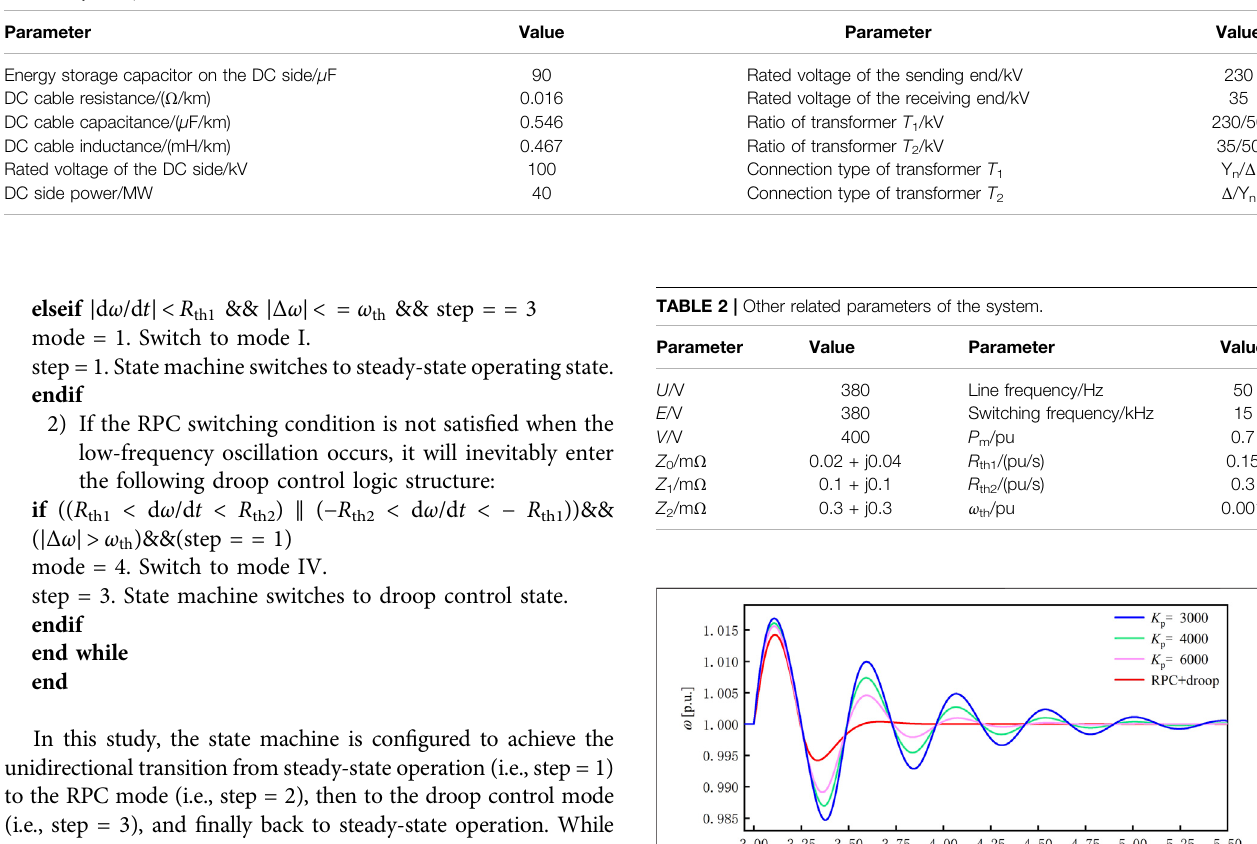
TABLE 1 | Main parameters of VSC-HVDC.